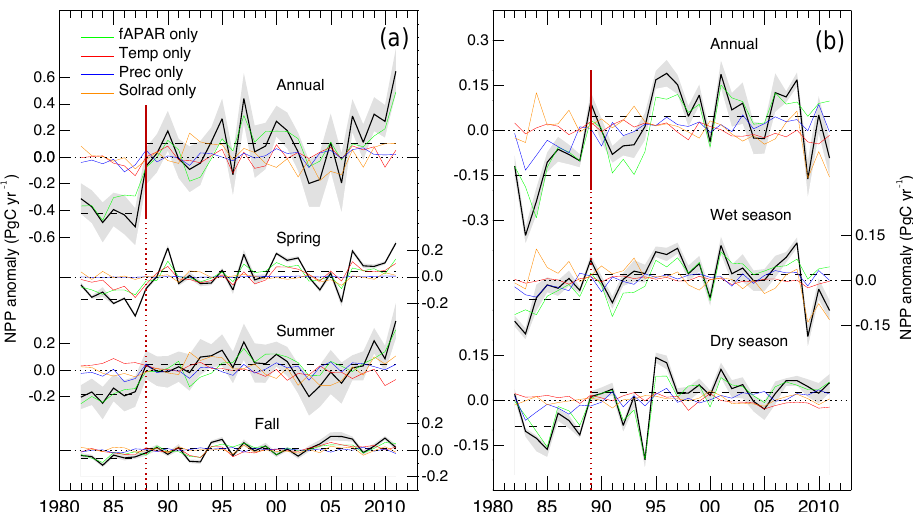
Figure 2. Temporal changes in continental data-driven NPP. Panels show annual and seasonal (CASA-based) NPP anomalies corresponding to the (a) northern Eurasian and (b) northern African focus regions (see Fig. 1a). All anomalies are relative to 1982–2011. Shaded contours represent 1 σ uncertainties that account for biases in model driver data (Sect. 2). To understand which factors are mainly responsible for the identified shifts (see Table 1), we performed factorial NPP simulations in which only one model driver is varied whereas all others are kept constant (e.g., “fAPAR only” corresponds to NPP simulations in which only fAPAR was varied whereas temperature, precipitation and solar radiation data were kept at their climatological mean values). It should be noted that satellite fAPAR, a proxy for vegetation cover, is often correlated with climate variables; this places limits on attributing a single model driver to changes in NPP. The first year of a new regime in annual NPP is outlined (thick dark-red vertical lines; see Table 1), and the means in NPP anomalies prior to and after the shift are also shown (dashed